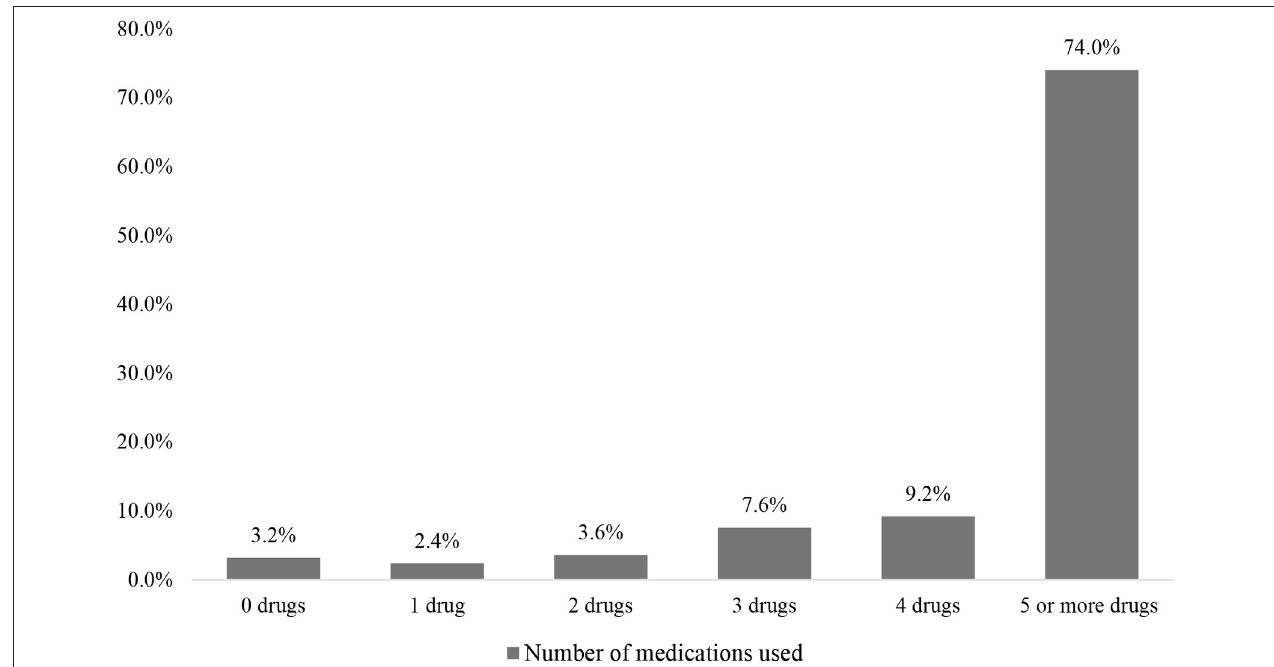
FIGURE 1 | The percentage of overall patients stratified by the number of drugs used. The results show the prevalence of polypharmacy (five or more drugs) to be 74% among older adults who underwent major